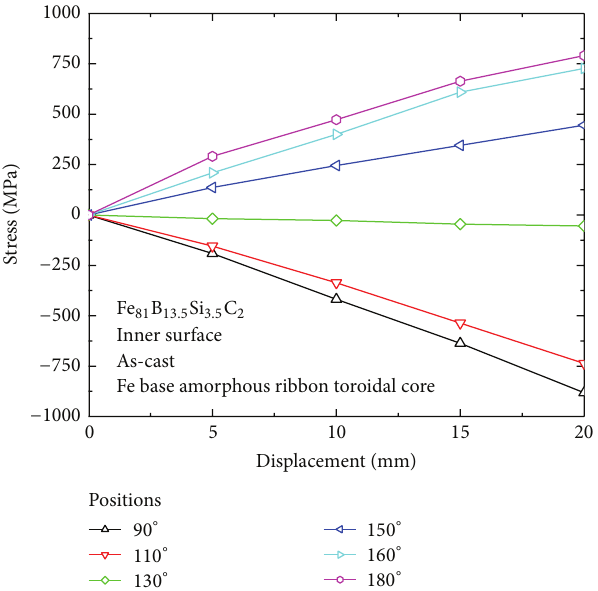
Figure 7: Stress distribution on the inner surface of the as-cast, Fe based, 0.5 mm thick, and 30 mm inner diameter amorphous toroidal transducer core for 90 ∘ , 110 ∘ , 130 ∘ , 150 ∘ , 160 ∘ , and 180 ∘ positions.